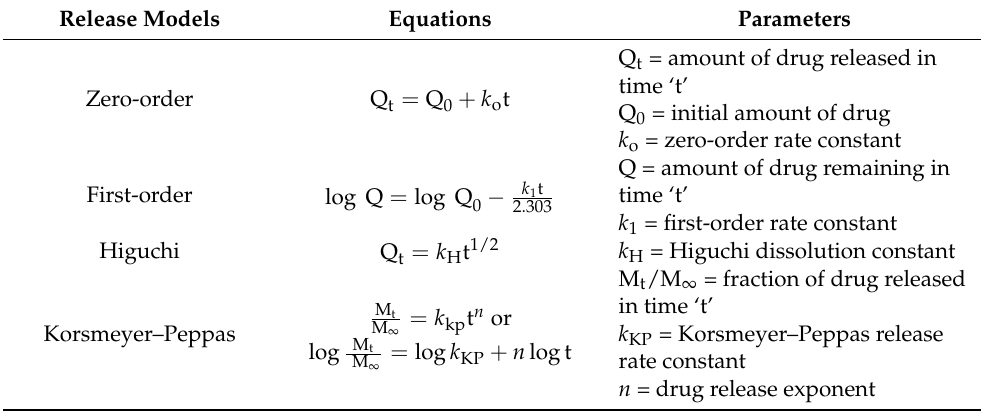
Table 1. Various drug-release kinetic